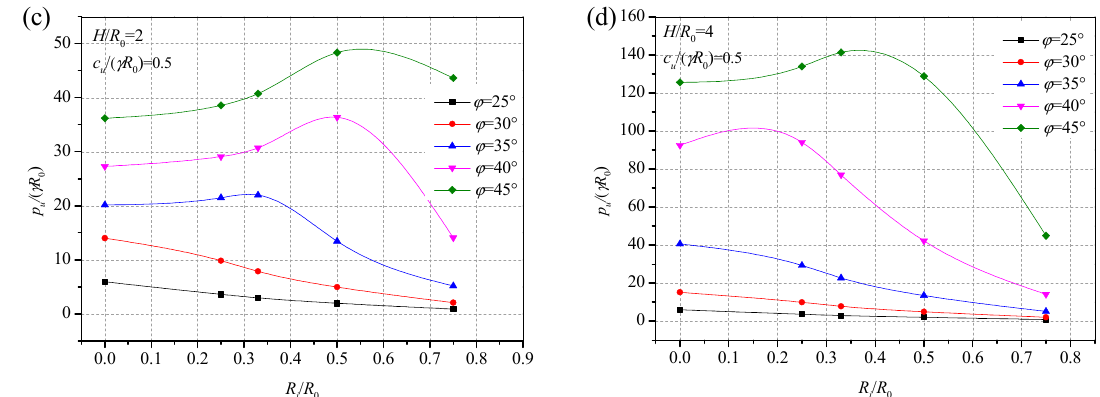
Figure 4. Variation in the normalized bearing capacity, p /( γ R 0 ), with R i / R 0 and φ for c u /( γ R 0 )=0.5 with